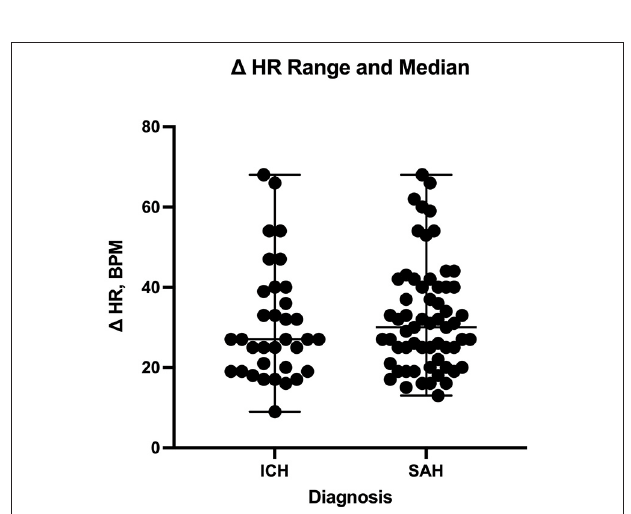
FIGURE 1 | Correlation between the number of enteral (PO) agents and systolic blood pressure delta. PO, per os (enteral); SBP, systolic blood pressure.